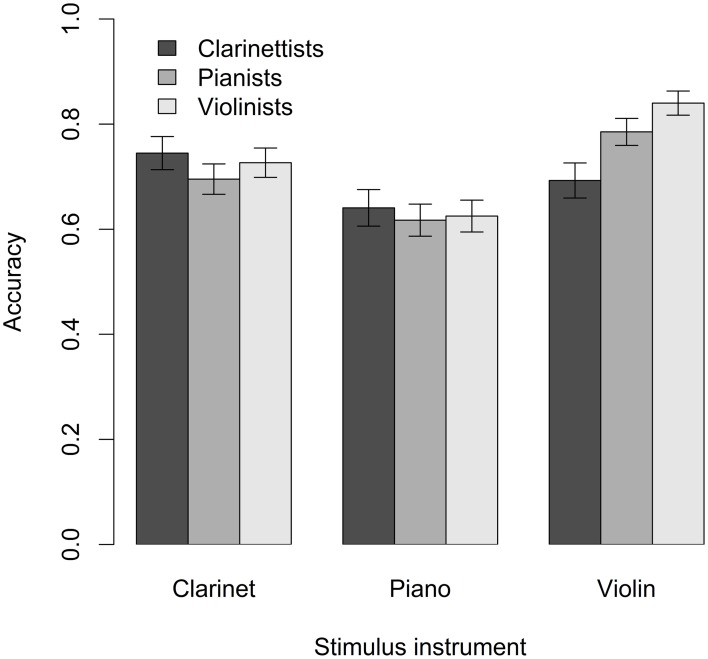
Pilot task response accuracy. Error bars indicate standard error.